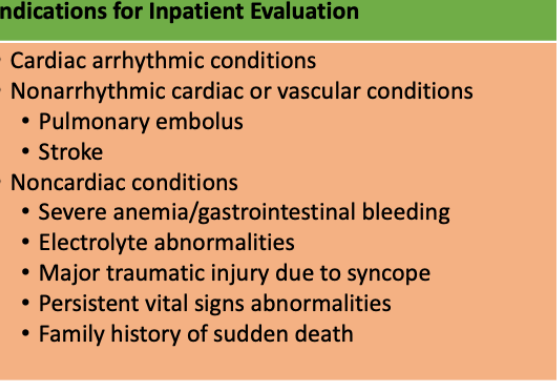
Figure 2. Indications for inpatient evaluation for patients with vasovagal syncope [11,36,42,43]. Further management of vasovagal syncope is outside of the scope of this